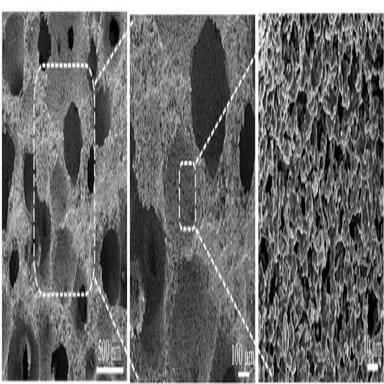
Microstructures of lightweight porous materials with varying AlF3⋅3H2O contents. (a) 0, (b) 3, (c) 6, and (d) and 9 wt%.